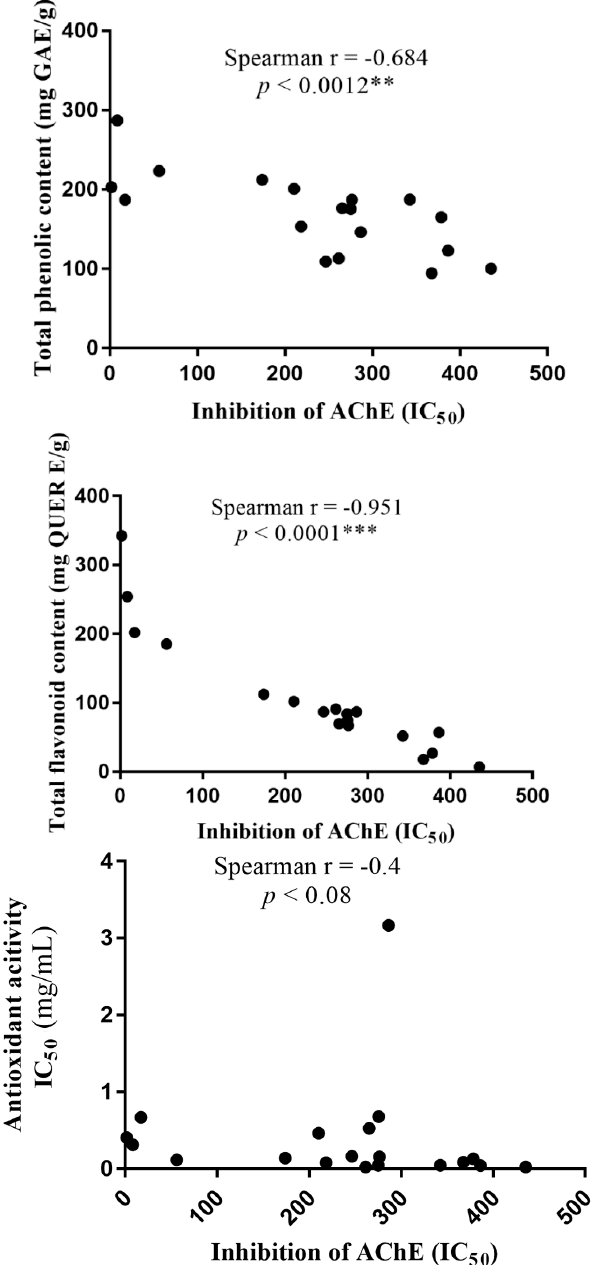
Figure 4. Spearman correlation of AChE inhibitory potency vs total phenolic content, total flavonoid content, and antioxidant potential for plant extracts from Moringa oleifera . Each dot represents one of the methanolic, aqueous, or ethanolic extracts. For significance, ** p < 0.01, *** p < 0.001.